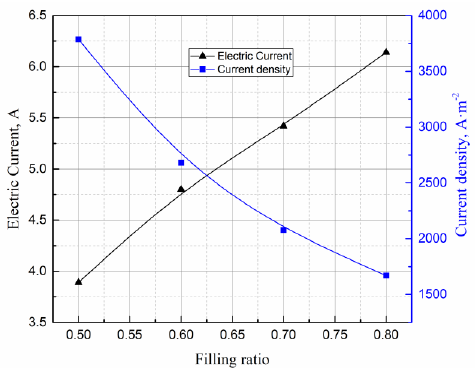
Figure 13. Variation of the current density and electric current at di ff erent filling rates in the physical simulation.